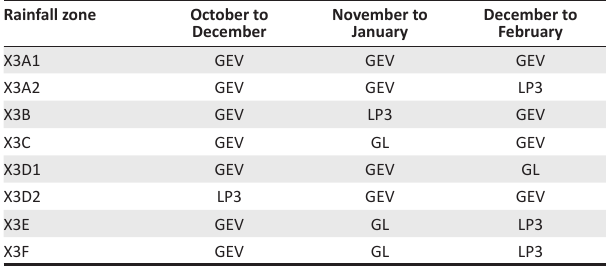
TABLE 6: Best fit distribution functions for the frequency analysis of agricultural drought events in growing periods.